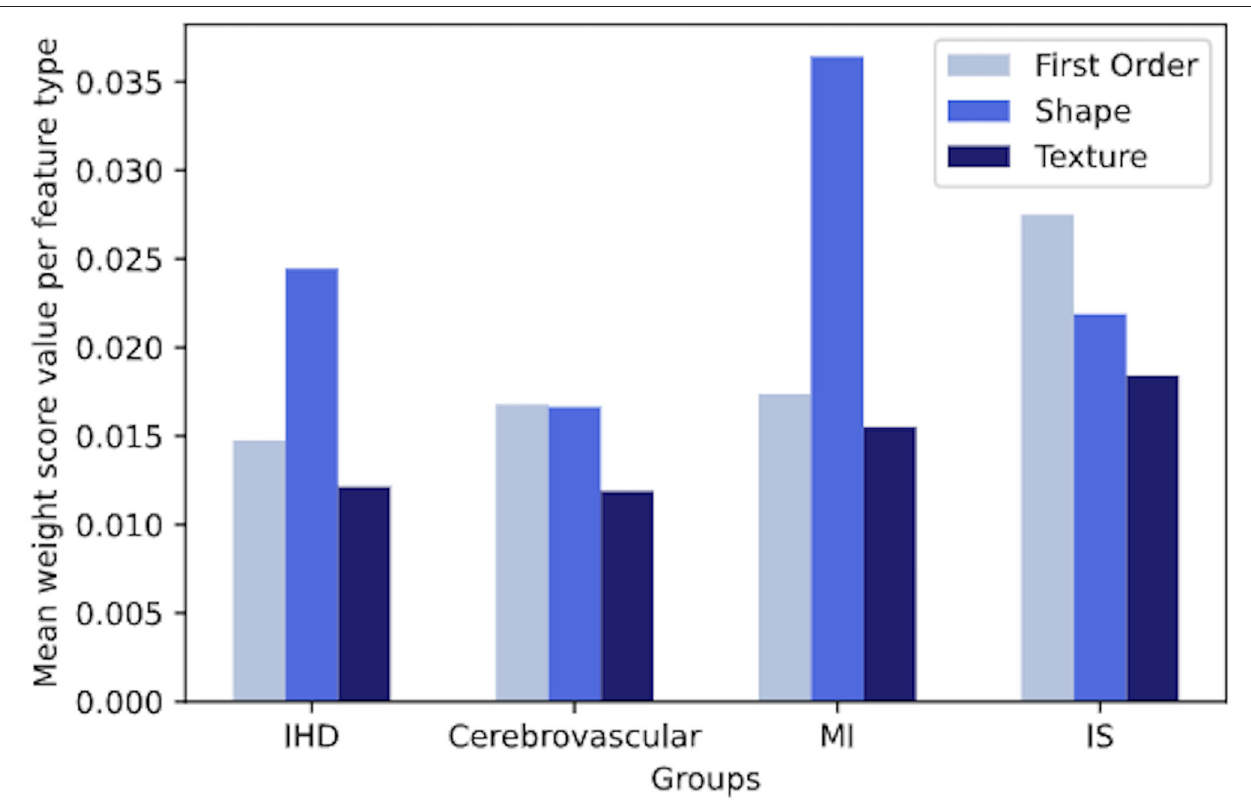
FIGURE 5 | The overall contribution of first-order, shape, and texture features to a signature in IHD, cerebrovascular disease, MI and IS groups, based on the mean weight value per each feature type. IHD, ischaemic heart disease; MI, myocardial infarction; IS, ischaemic stroke.